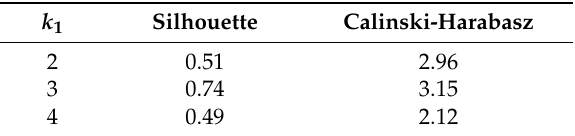
Table 1. Silhouette and Calinski-Harabasz measures for different k 1 (i.e., the number of clusters at the first step of the proposed approach).